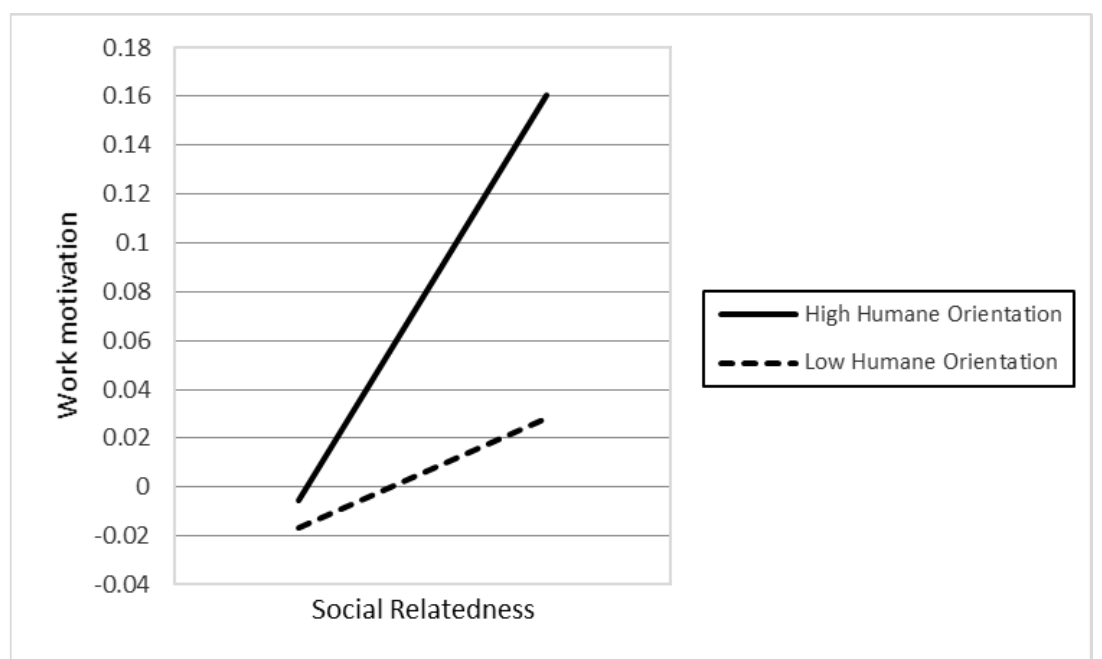
Figure 5. The association between social relatedness and work motivation at different levels of humane orientation.